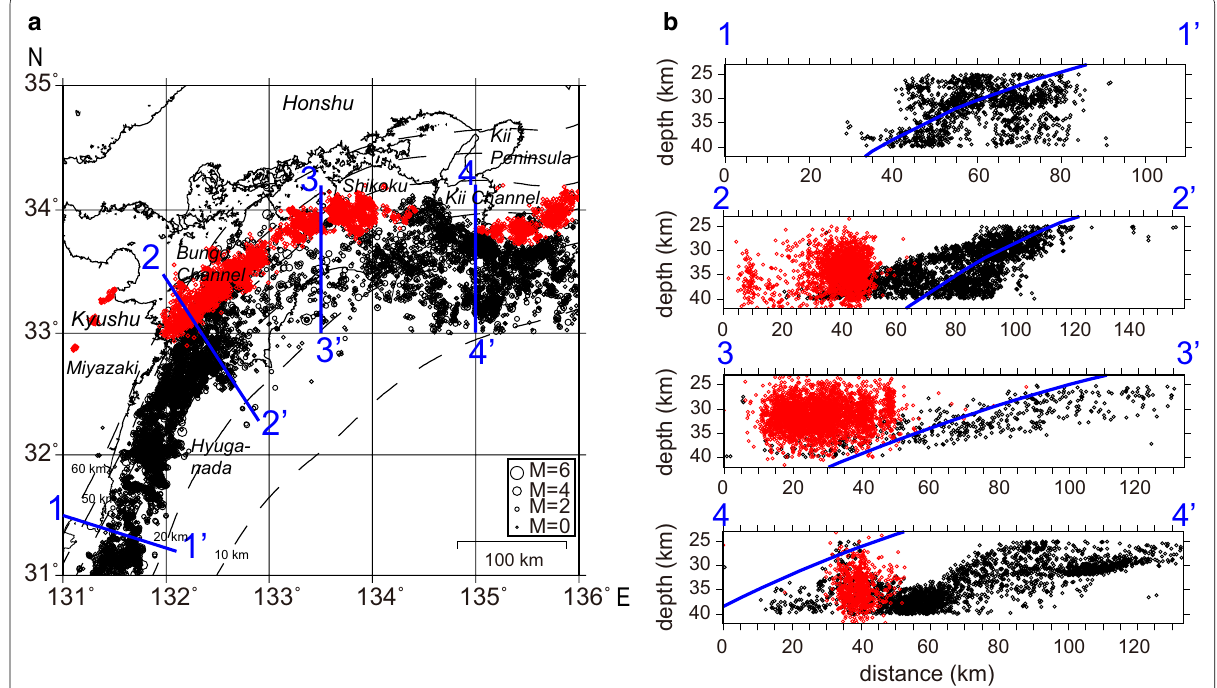
Fig. 1 a Epicenter distributions of M ≥ 1.4 earthquakes at depths of 25–40 km obtained from the JUICE catalog (black circles) and of low-frequency earthquakes (LFEs) at depths of 20–50 km obtained from the JMA unified catalog (red circles). Non-LFE earthquakes are scaled by magnitude. Dotted black lines correspond to isodepth contours of the plate interface with labels in kilometers (Hayes et al. 2018). Four blue lines represent the locations of the cross sections in b . b Hypocenter distributions projected onto four vertical transects in a . All events that occurred within 50 km of each transect are plotted. Blue lines represent the upper surface of the subducting plate by Hayes et al.